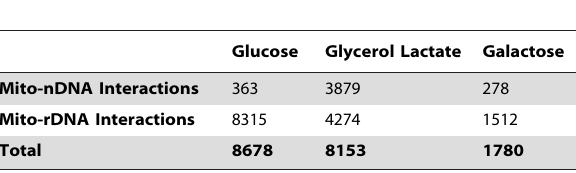
Table 1. Inter-organelle interactions are carbon source